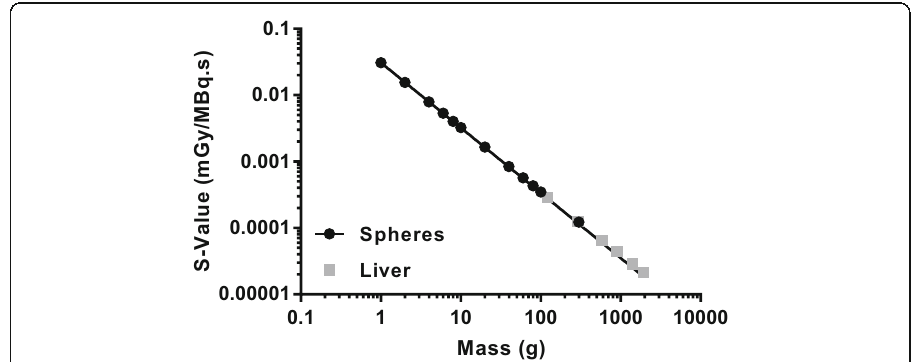
Fig. 8 Plot of liver and sphere S values used to determine the patient specific S value used for dose